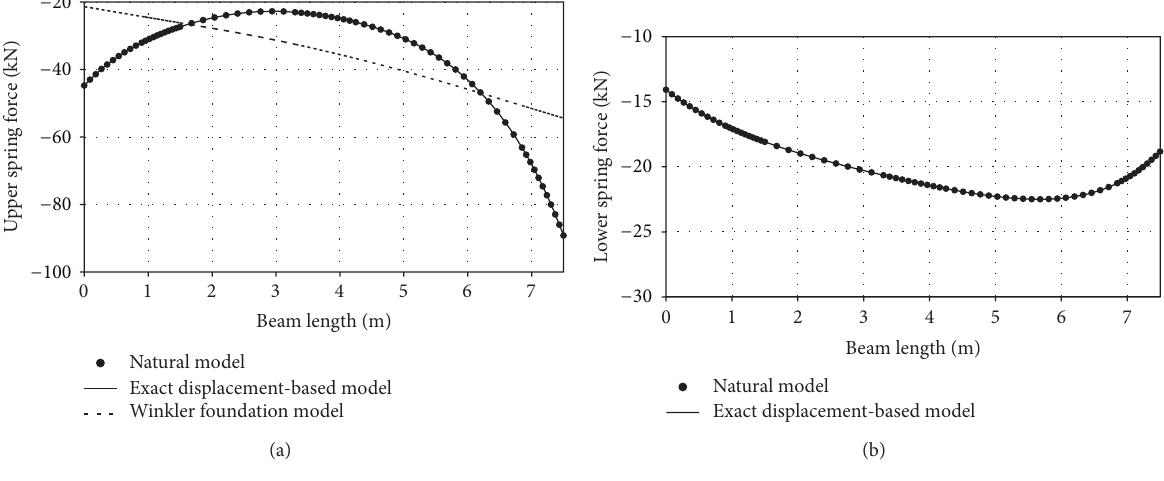
Figure 7: Diagrams for upper and lower spring foundation